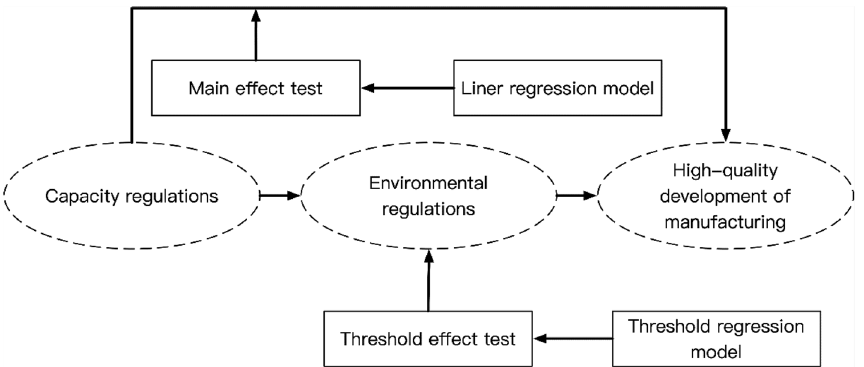
Figure 1. The conceptual framework.